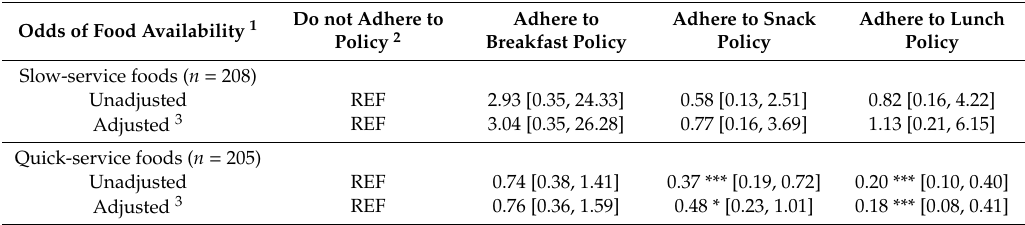
Table 3. Odds ratios and 95% confidence intervals for slow- and quick-service food availability by breakfast, snack and lunch policy